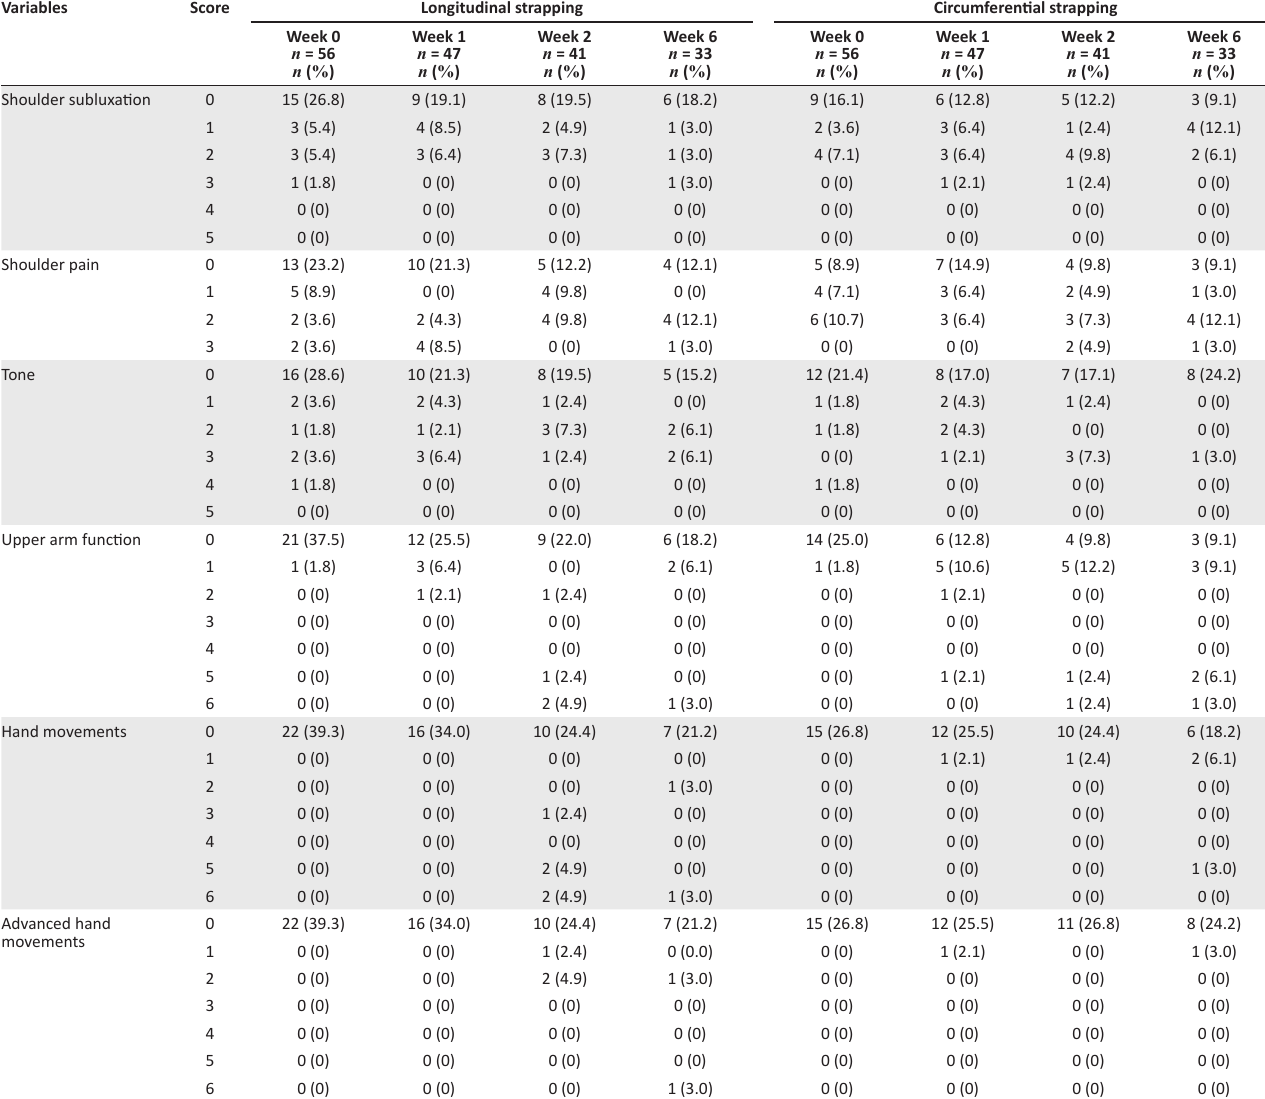
TABLE 6: Changes in outcomes between the longitudinal and the circumferential strapping group over a 6 week period. Variables Score Longitudinal strapping Circumferential strapping